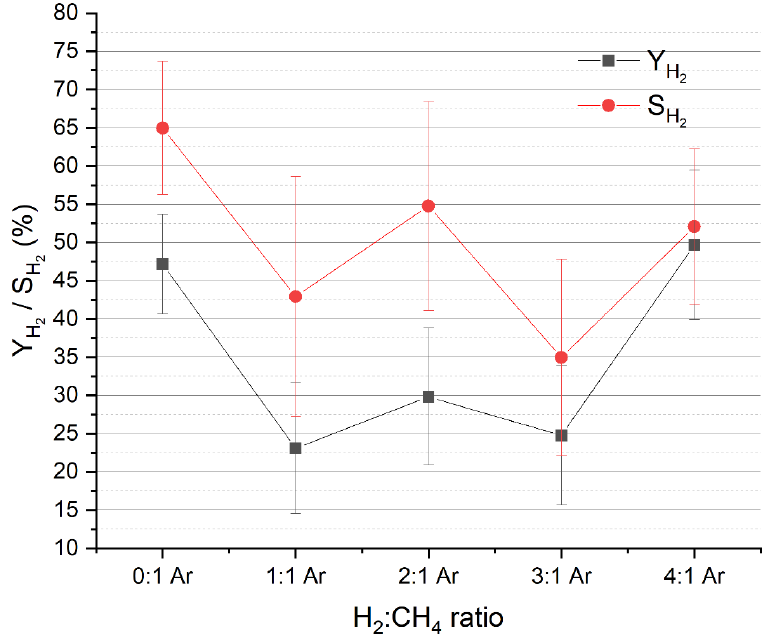
Figure 7. Changes in hydrogen yield and selectivity depending on H 2 :CH 4 ratio.